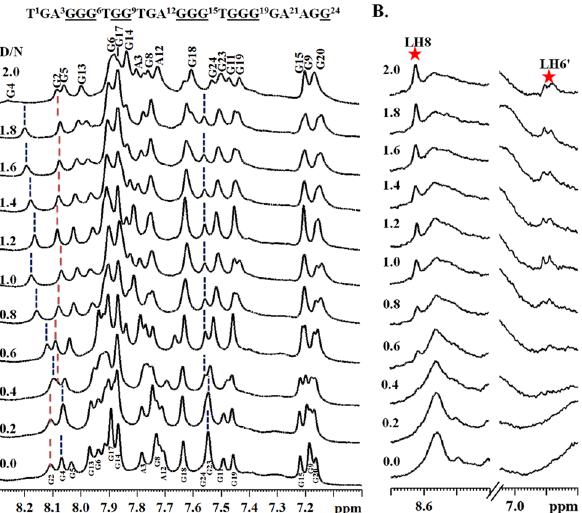
Figure 6. Base region of one dimensional proton spectra for Quercetin - Pu24T complex. ( A ) 1 H NMR spectra showing the interaction of Quercetin with Pu24T monitored by base region as a function of D/N ratio at 298 K (Changes in the chemical shift for G4, G2, G24 were followed by blue dotted lines from D/N = 0.0 to D/N = 2.0. ( B ) Interaction of Quercetin with Pu24T showing proton resonances from Quercetin (LH6 ′ and